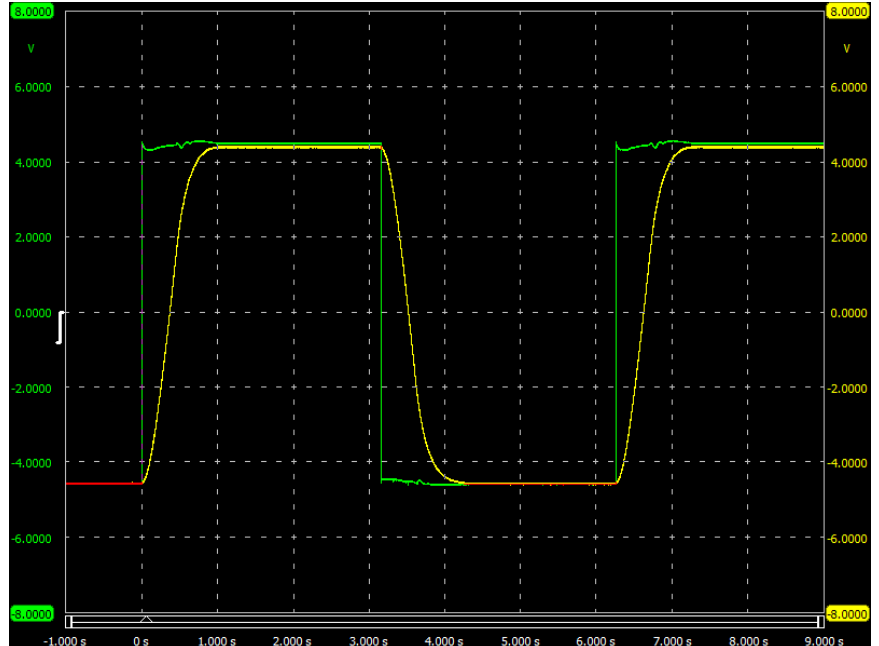
Fig. 8. Output response with ringing removed by velocity feedback (op amp-based